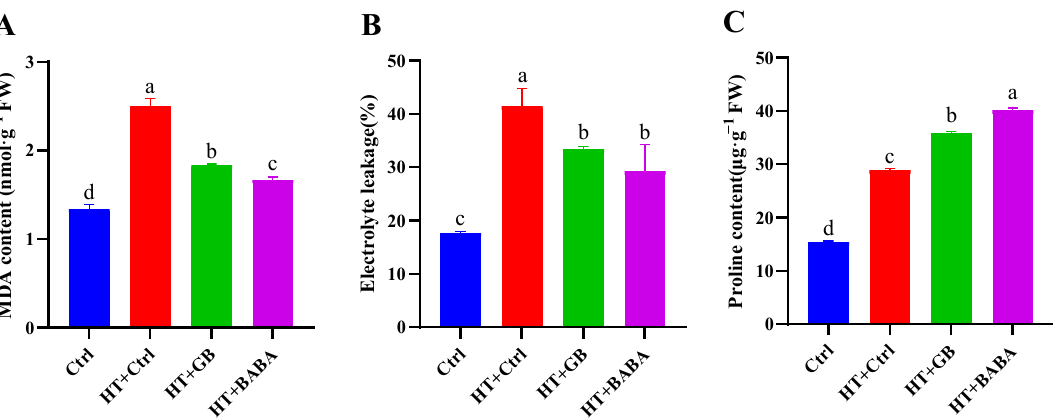
Figure 2. Effects of GB and BABA on MDA content ( A ), electrolyte leakage ( B ), proline content ( C ) in Chinese cabbage under heat stress. Data are shown as mean ± SD. Different lowercase letters indicate significant difference at p < 0.05. Ctrl, optimum conditions; HT + Ctrl, HT + GB, and HT + BABA seedlings were foliar sprayed with water, GB, and BABA, respectively, before exposure to high temperature.